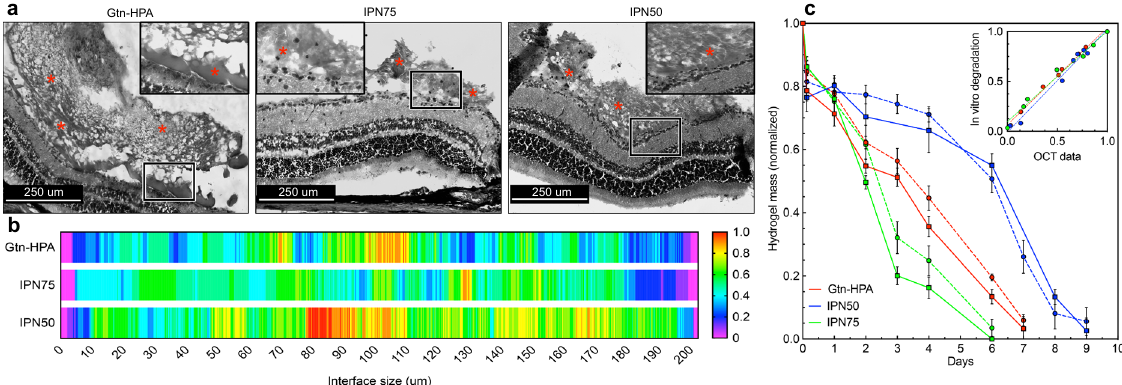
Fig. 3 In vivo proof of attachment of hydrogel candidates to the inner limiting membrane (ILM) of the retina. a Hematoxylin and Eosin (H&E) staining of rat ’ s retina 3 days post hydrogel injections for Gtn-HPA, IPN75, and IPN50 groups. Images were taken under bright- fi eld microscopy at 10X and 63X magni fi cation for respectively large image and inset. Hydrogel presence is observed and labelled with red stars. Inset shows higher magni fi cation and interface of gel with ILM to prove attachment. The scale bar is 250 um. b . Analysis of hydrogel-ILM interface from H&E staining with heat map. 200 um length interfaces were analyzed for all three samples. Heat map ranges from 0 with no attachment at the interface to 1 with attachment seen on all different slides. c . Gtn-HPA, IPN75, and IPN50 hydrogels mass degraded through time during in vivo injection compared with in vitro degradation. In vitro degradation (plain lines) was performed using concentrations of collagenase and hyaluronidase found in the eye 30,31 , while in vivo degradation was measured using SD-OCT and image processing (for more information see Method and Supplementary Fig. 10). Normalized hydrogel mass was measured for N = 15 replicates every 1 – 2 days. The correlation coef fi cient between in vitro and in vivo was measured and are shown in inset . R 2 = 0.97 was found for all samples with no statistical difference found between in vivo and in vitro data. Data are shown as mean ±